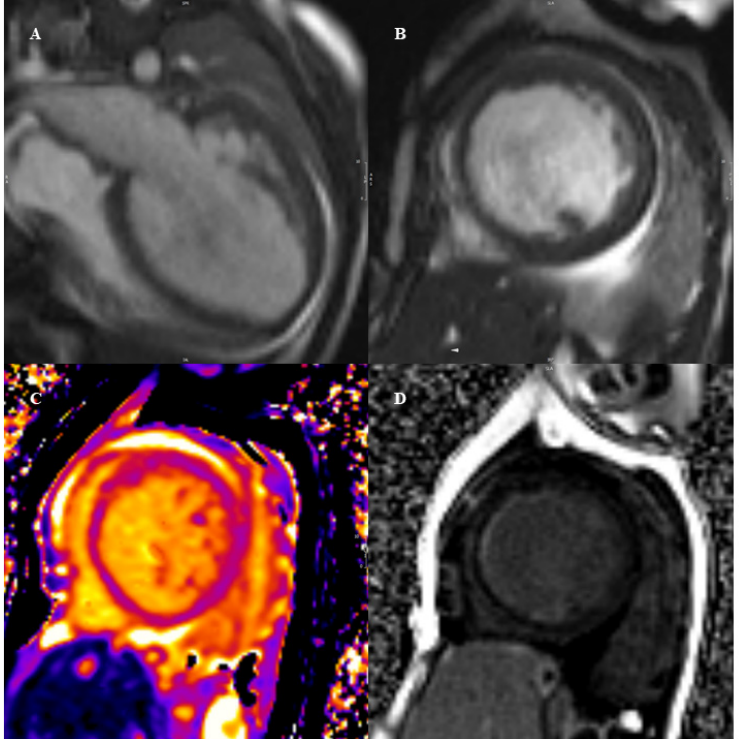
Figure 1. A case of DCM in a 6-year-old child, male. Cine sequences documented diffuse hypokinesia, septal dyssynergy and severe left ventricular dilatation (left ventricular end diastolic volume indexed 158 mL/m 2 ) with a severely compromised ejection fraction (LVEF 12%) as shown in panels ( A , B ). The T2-mapping sequences showed diffusely elevated T2 values (72–75 ms), as a sign of concomitant myocardial edema (panel ( C )), which was not evident in T2-weighted imaging. Late gadolinium enhancement was suggestive for septal mid-wall hyperenhancement (panel ( D